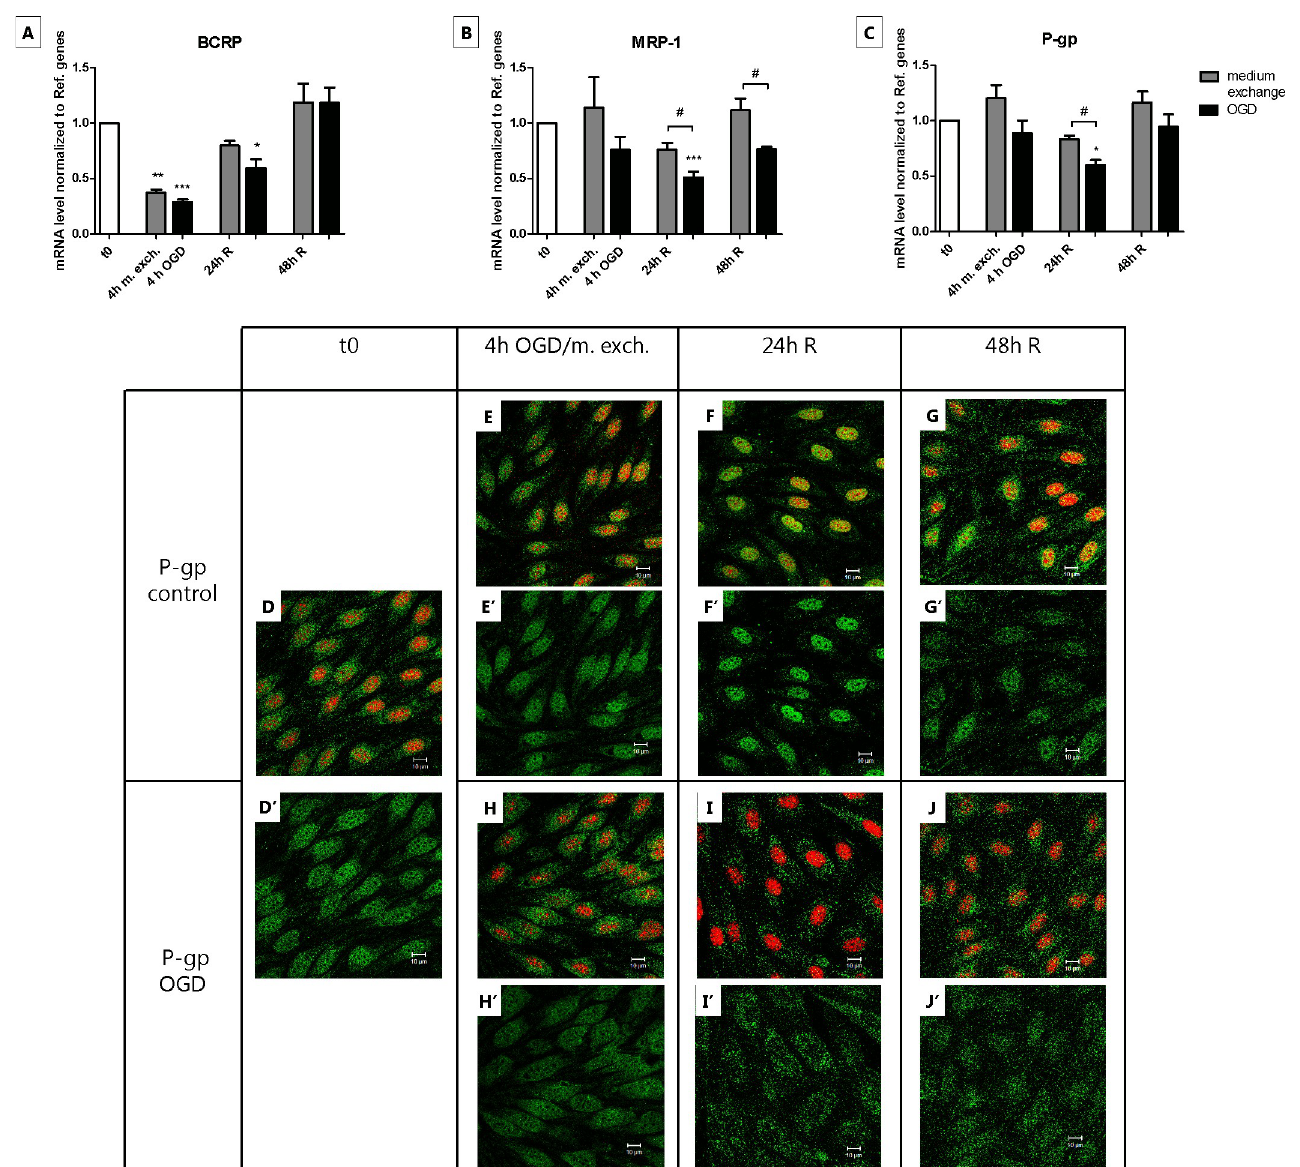
Fig 8. Transcript level of BCRP, MRP-1 and P-gp and cell localization of P-gp in endothelial cells before, during and after 4 h of oxygen-glucose deprivation (OGD) or medium exchange. The mRNA levels of BCRP (A), MRP-1 (B) and P-gp (C) at the different time points of the OGD (black bars) and medium exchange (gray bars) protocol were measured by RT-qPCR and normalized to reference genes. Primers specifically designed for bovine orthologues were utilized. Bar graphs represent means and error bars are +SEM. N = 3, n = 3–4. Columns were compared to t0 using one-way ANOVA and Dunnett’s multiple comparison post-test. � : p < 0.05, �� : p < 0.01, ��� : p < 0.001. Bonferroni’s post-test was utilized to compare each pair of columns. #: p < 0.05. Figs D-J show antibody staining of P-gp (green), and cell nuclei staining with propidium iodide (red) under the different treatments. Figs D’-J’ show exclusively the P-gp staining from Figs D-J. Bars = 10 μ m. N = 1; n =